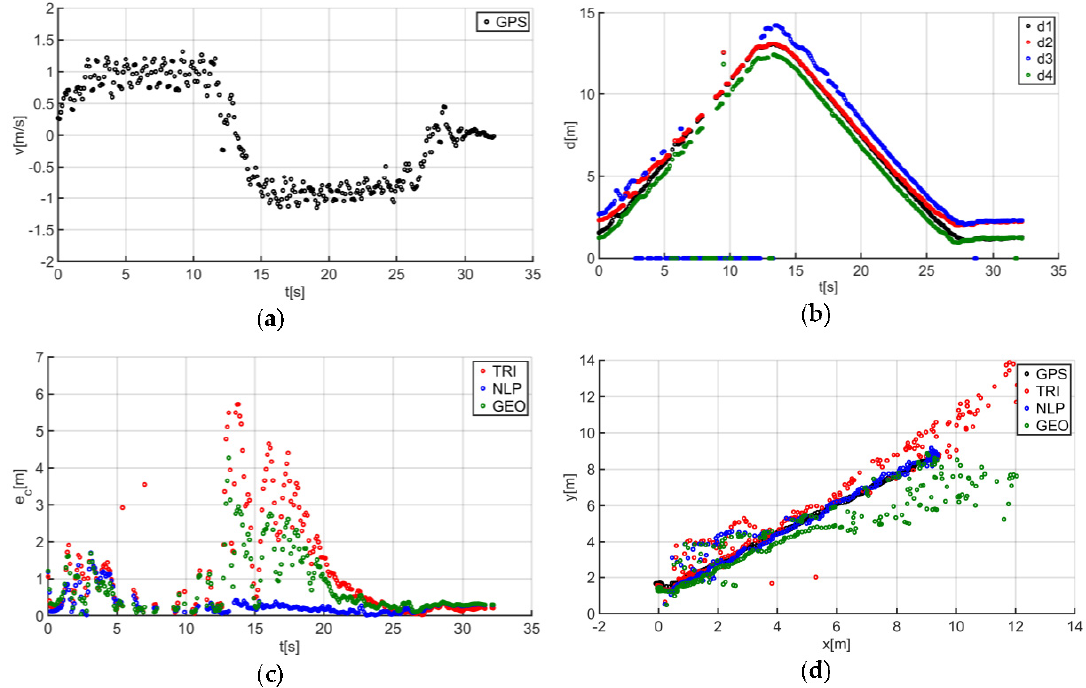
Figure 19. Test results no. 6: ( a ) human guide speed v p (t) and ( b ) filtered distance from anchors d i (t), i = 1, 2, 3, 4; ( c ) course of total location errors e c (t) and ( d ) location of the human guide y p (t) = f(x p (t)).